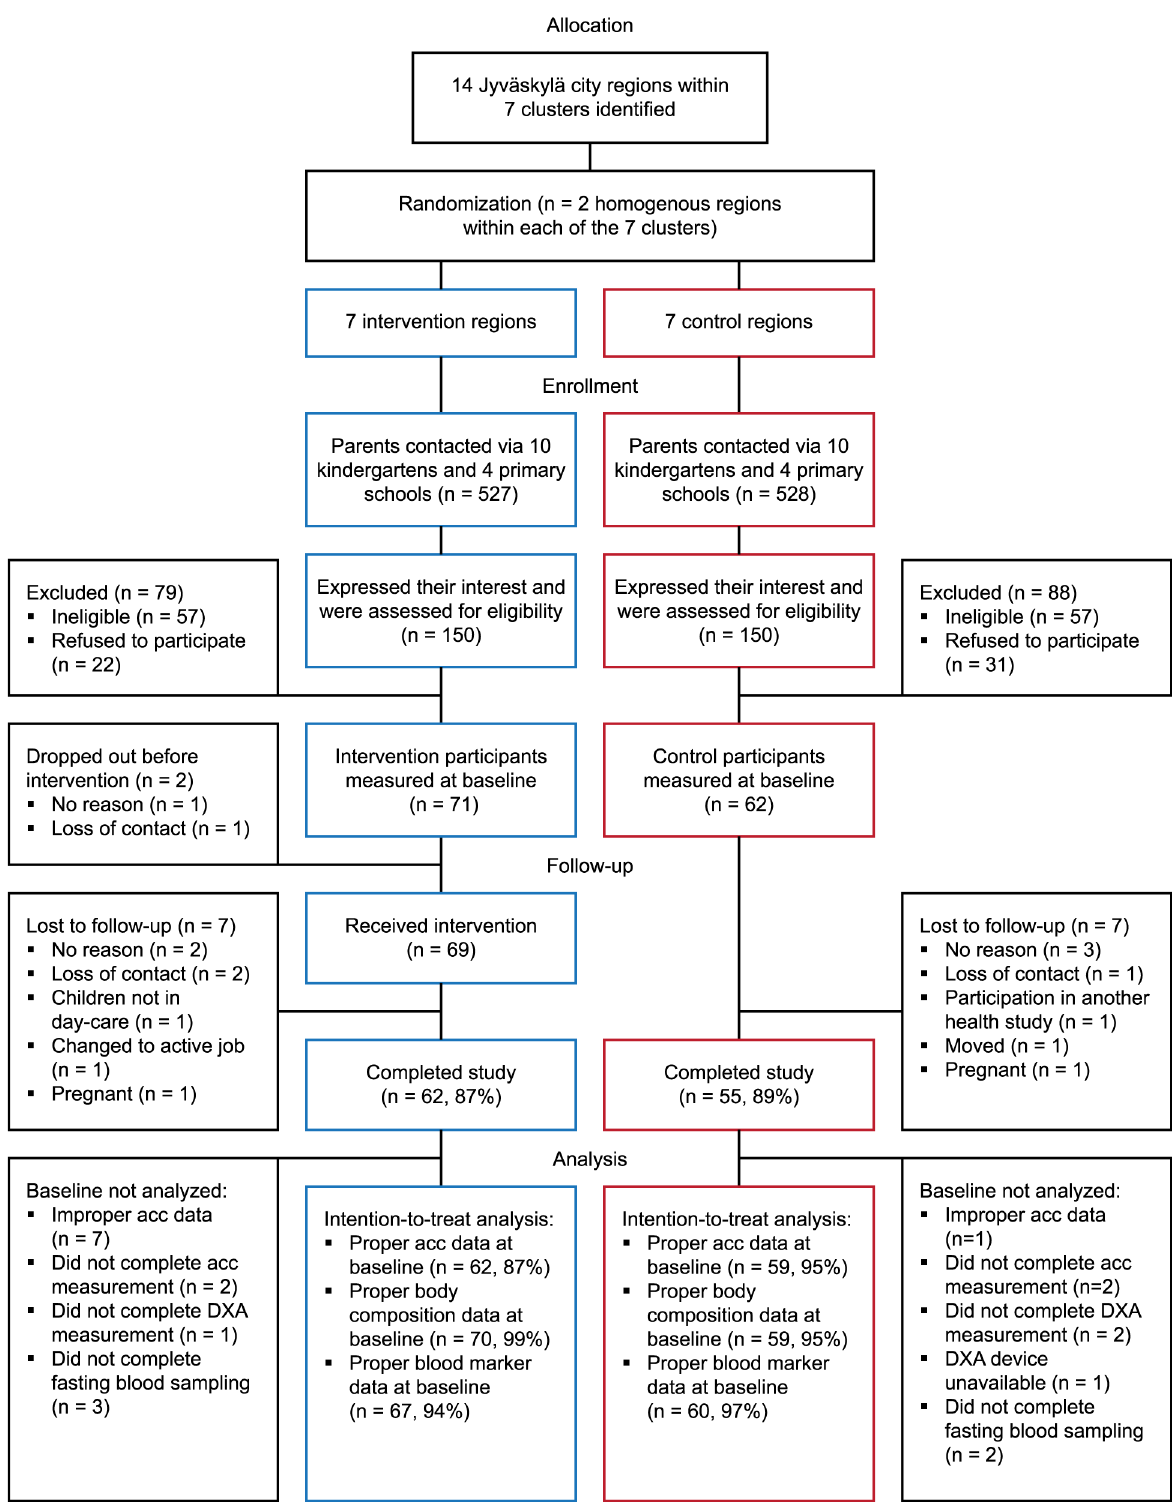
Fig 1. Flow chart of the study. Footnote: acc; accelerometer.